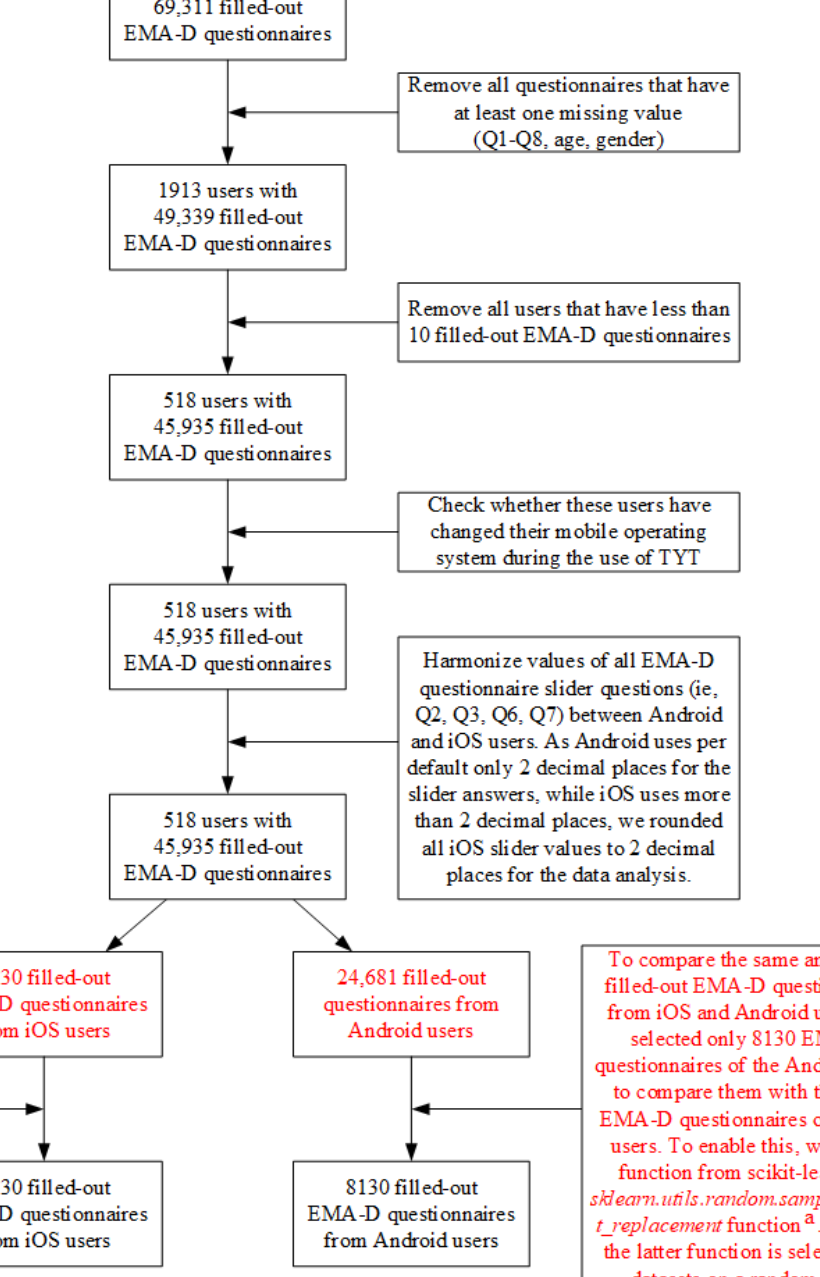
Figure 2. Data preparation steps for the machine learning analysis. a Information about the scikit-learn function can be found on the scikit-learn website [33]. EMA-D: dynamic ecological momentary assessment; Q: question; TYT: